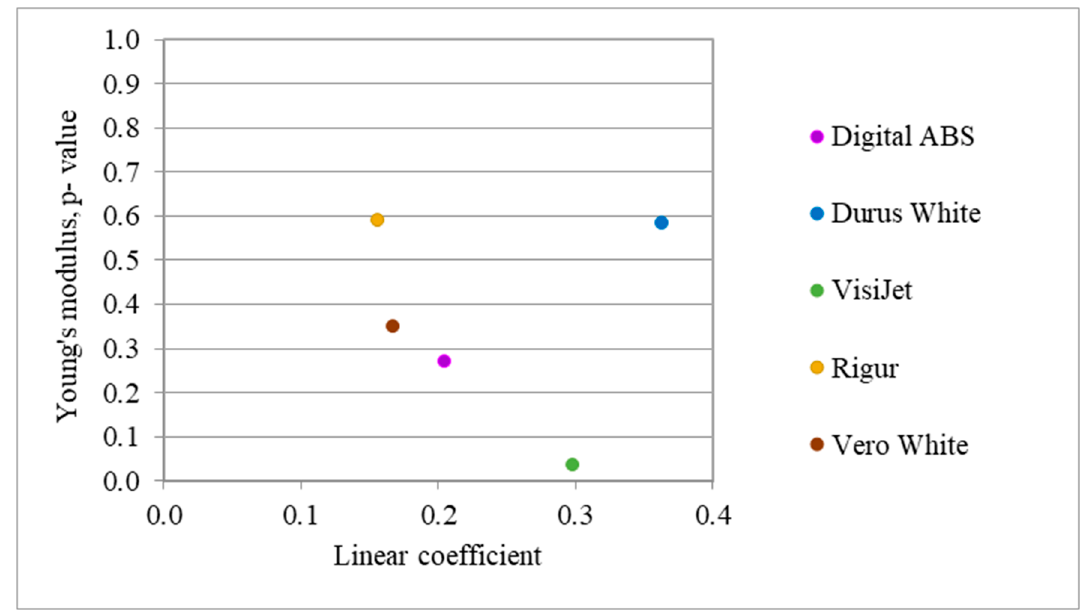
Figure 9. List of materials in terms of isotropy and linearity.